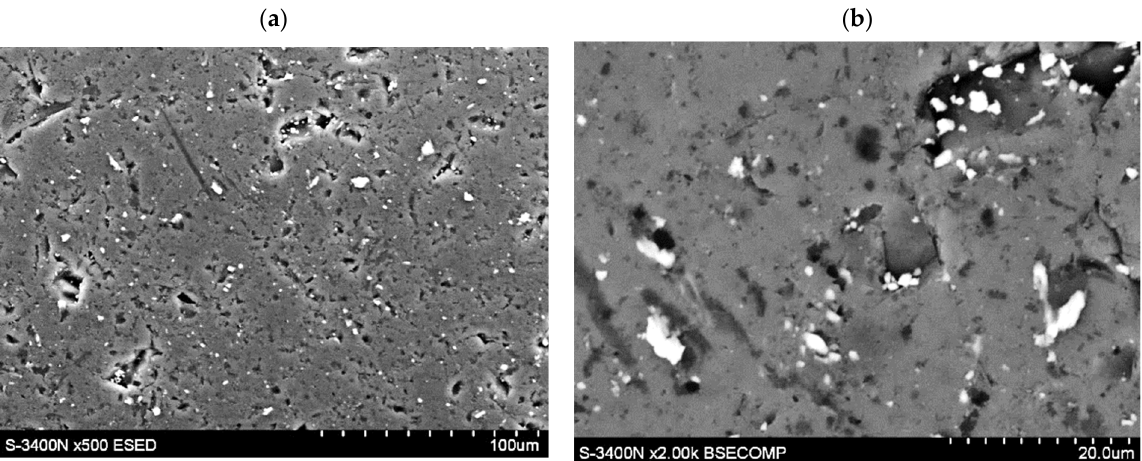
Figure 6. ( a , b )-Local presence of discontinuities in TiCrFeCoNi layer of the applied HEA.